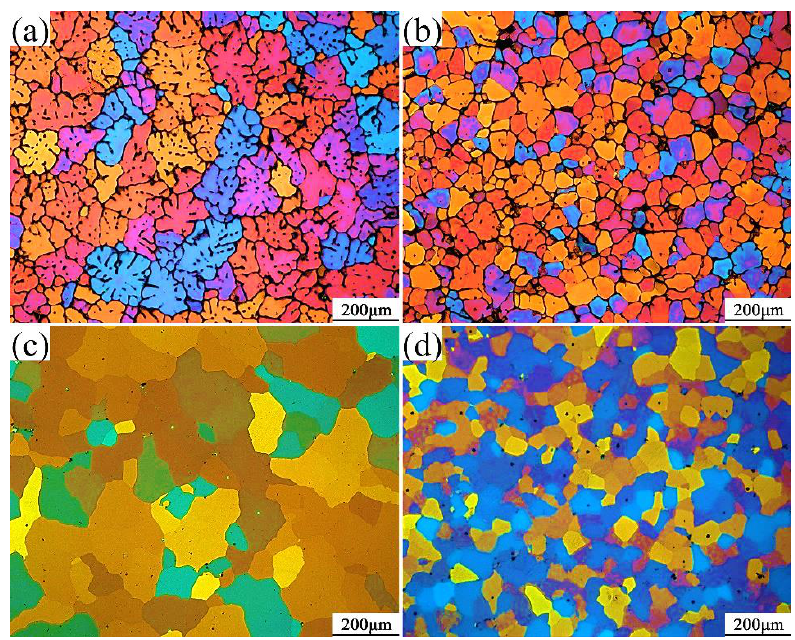
Figure 3. The microstructure of the alloy squeeze casting into a solid cylindrical part under different conditions: ( a ) as-cast, no Sc; ( b ) as-cast, 0.15% Sc; ( c ) heat-treated state, no Sc; ( d ) heat-treated state, 0.15% Sc.